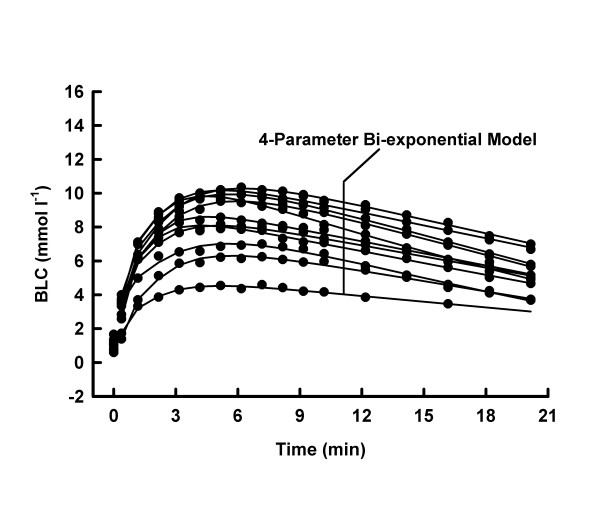
BLC, individual 4-parameter model approximations for MSE10.